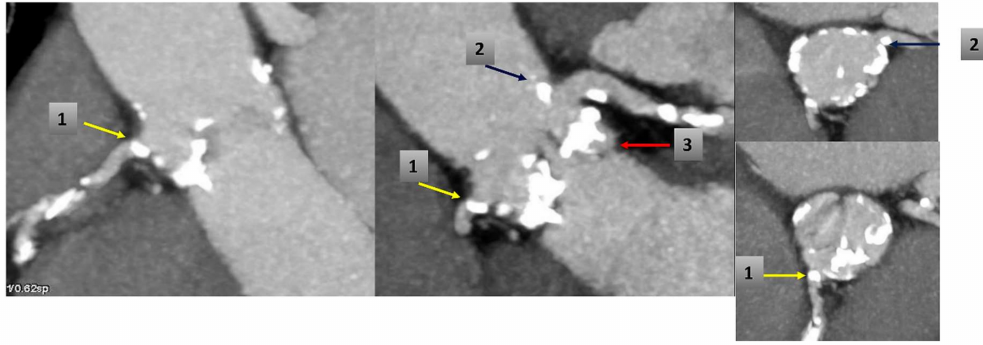
Figure 4. CT scan before TAVR shows: (1) RCA ostium calcification (yellow arrow); (2) calcification near ostium of the Left Main (blue arrow) and (3) calcified native valve under left coronary ostium (red